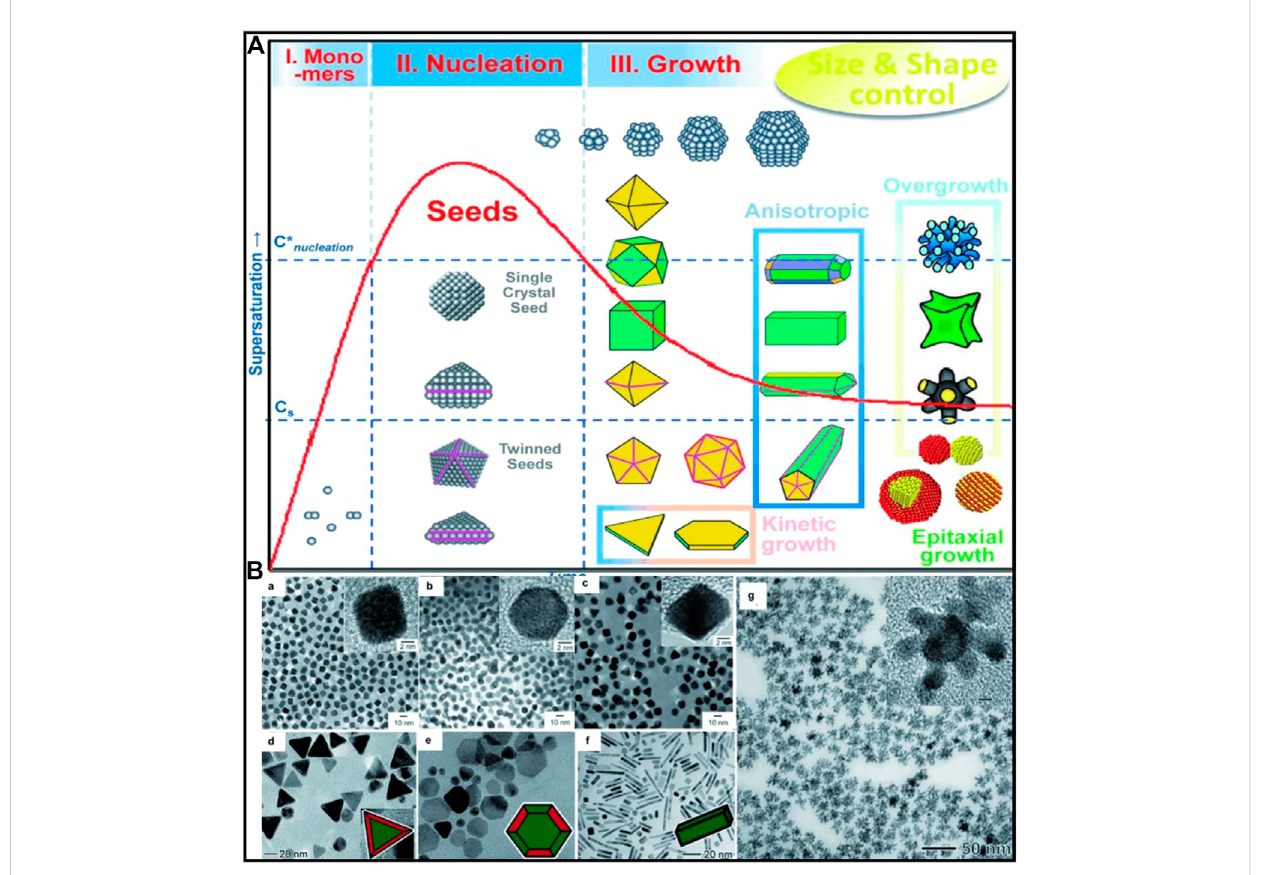
FIGURE 3 General synthesis strategiesfor sizeand shapecontrolled MNPscombined withLaMerrepresentation (A) .HRTEMimagesofshapecontrolled MNPs (B) :cubeNPs(b,a), cuboctahedraNPs (B) ,octahedra NPs(b,c), triangular plates NPs(b-d),hexagonalNPs (b-e),nano-barsNPs(b-f),nano-dendritesNPs (b-g). Reproduced with permission (An and Somorjai, 2012). Copyright 2022, John Wiley and